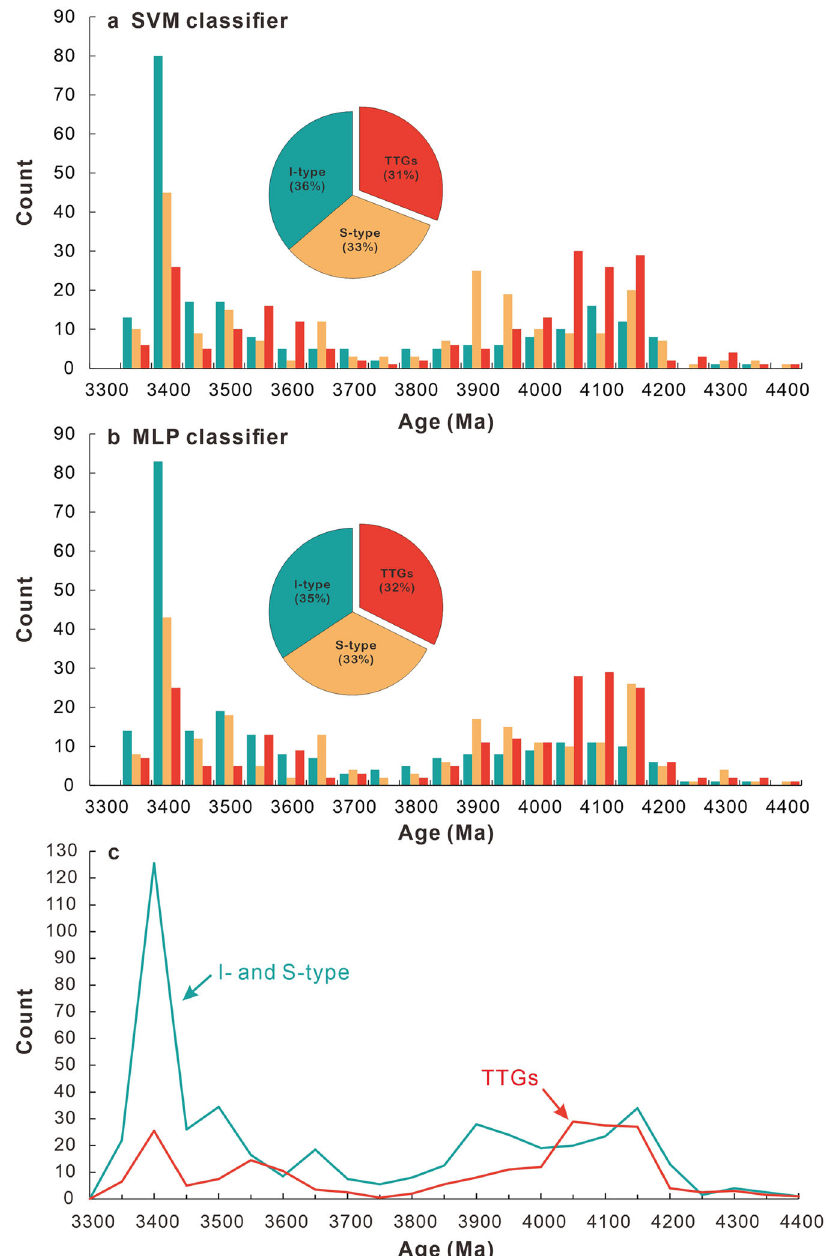
Fig. 3 Provenance of the compiled JH zircons. a Classi fi cation result based on the trained SVM model. b Classi fi cation result based on the trained MLP model. c The average distribution of zircon types with